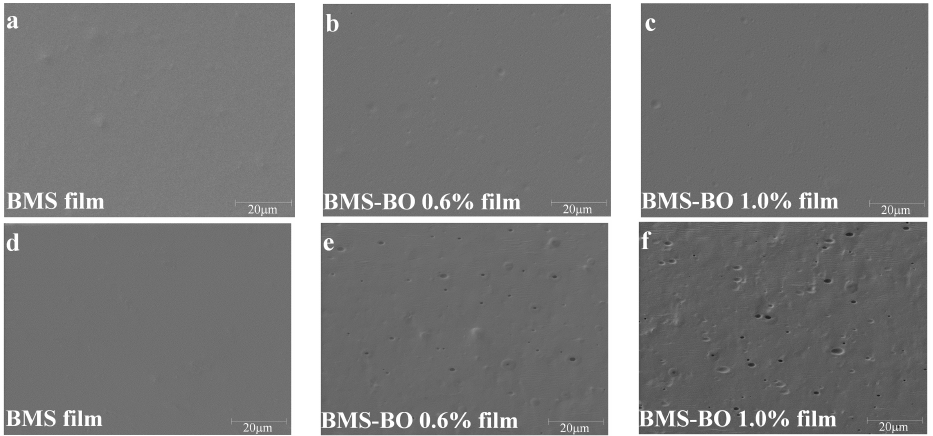
Figure 2. Surface SEM images of the ( a ) BMS film, ( b ) BMS-BO 0.6% film, and ( c ) BMS-BO 1.0% film. Cross-sectional SEM images of the ( d ) BMS film, ( e ) BMS-BO 0.6% film, and ( f ) BMS-BO 1.0% film. Magnification: 3000 × and 2000 × for surface and cross-section, respectively.